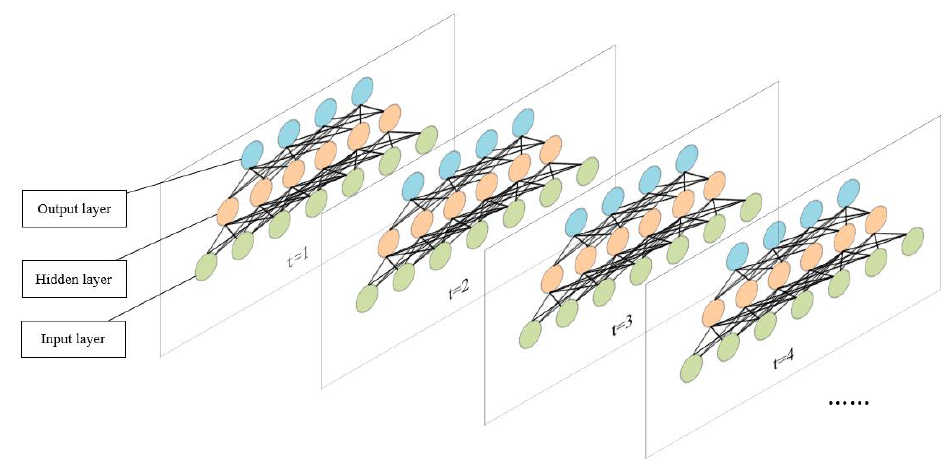
Figure 2. The internal structure of the LSTM-NN.